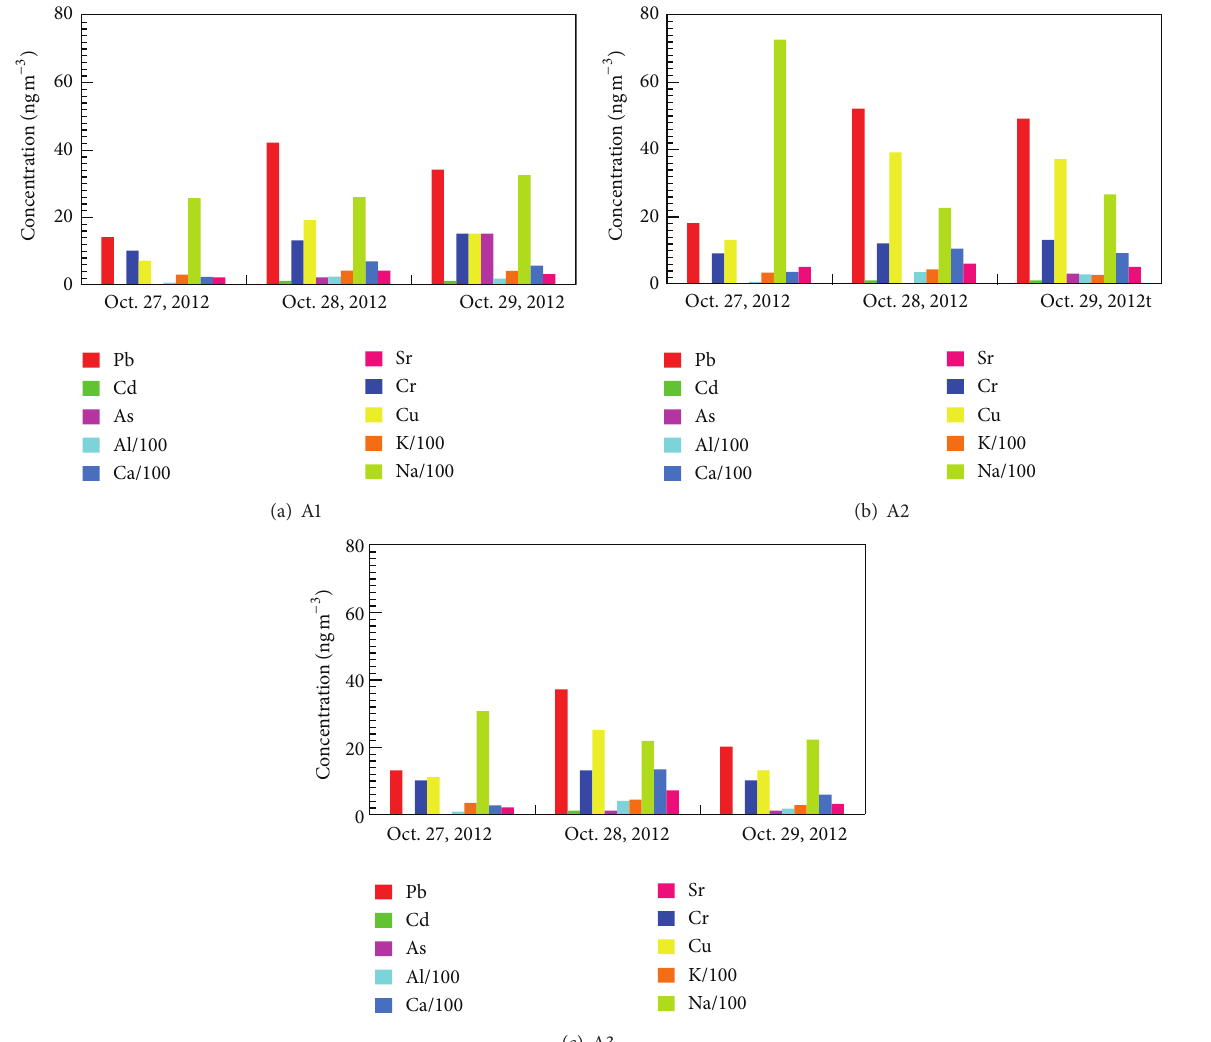
Figure 3: Concentrations of metals and elements during the Busan Fireworks Festival event (Oct. 28) in 2012, measured at three monitoring sites (A1–A3). The concentrations of K, Ca, Al, and Na were scaled down by a factor of 100.